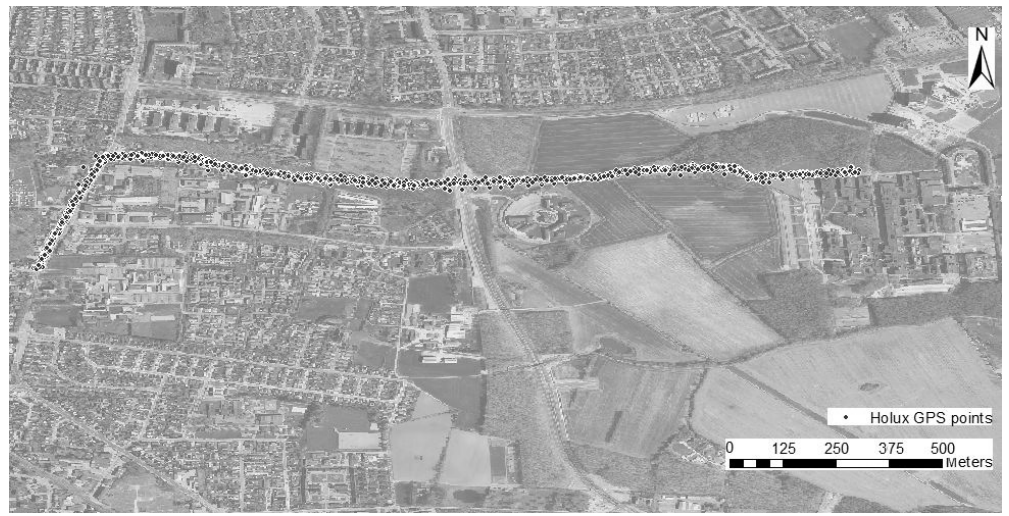
Figure 1. GPS points from Holux device projected on the aerial photo of Odense (Denmark).